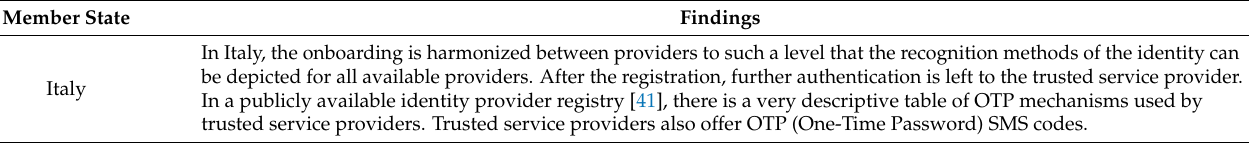
Table 7. Technical authentication for